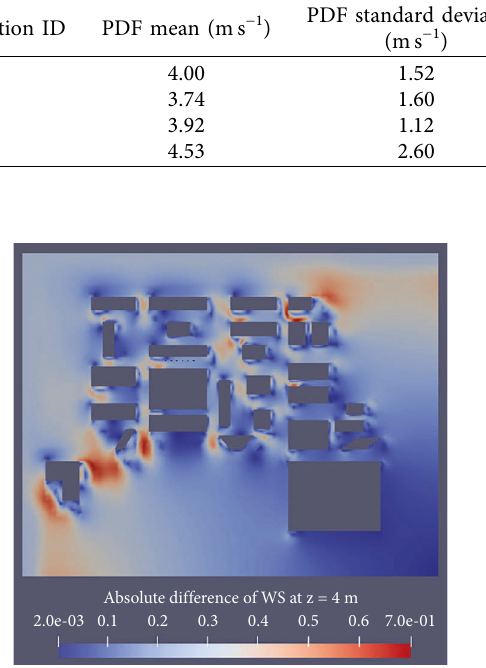
Figure 11: Absolute difference of predicted wind speed between two simulation: (1) Lh � Lv � 1km and (2) Lh � 1km and Lv � 500m.